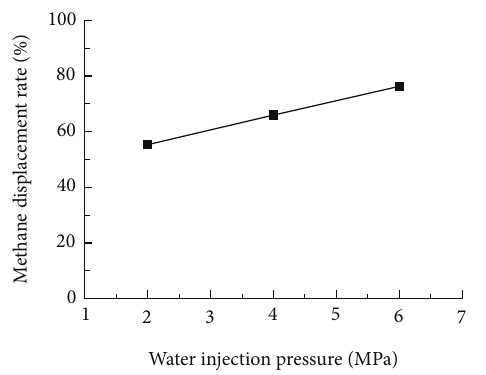
Figure 8: Methane displacement rate under di ff erent water injection